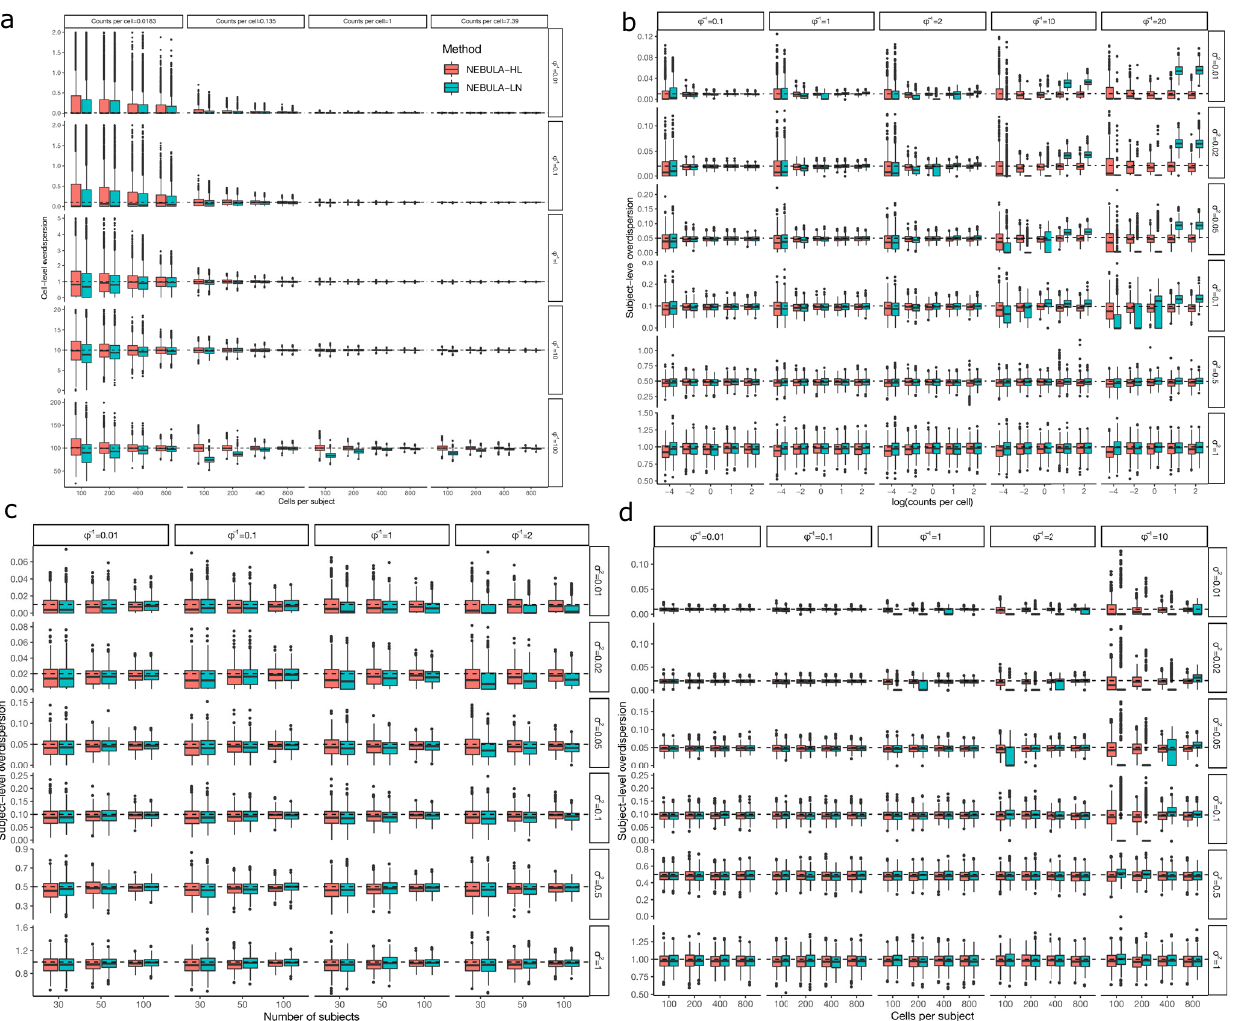
Fig. 2 Comparison of estimated cell-level and subject-level overdispersion parameters between NEBULA-LN and NEBULA-HL. a The cell-level overdispersion estimated by NEBULA-LN and NEBULA-HL under different combinations of CPS, β The number of subjects was set at 50. b The subject-level overdispersion estimated by NEBULA-LN and NEBULA-HL under different combinations of β σ 2 , and ϕ . The number of subjects was set at 50. The CPS value was set at 400. c The subject-level overdispersion estimated by NEBULA-LN and NEBULA- HL under different combinations of the number of subjects, σ 2 , and ϕ . The CPS value was set at 400, and β overdispersion estimated by NEBULA-LN and NEBULA-HL under different combinations of CPS, σ 2 , and ϕ . The number of individuals was set at 50, and β was set at 1. The summary statistics were calculated from n = 500 simulated replicates in each of the scenarios. The estimates from NEBULA-HL presented in these panels were based on the fi rst-order Laplace approximation, and the results comparing the fi rst-order and higher-order LA methods in NEBULA-HL were presented in Supplementary Fig. S17. CPC: counts per cell. Center line: median. Box limits: upper and lower